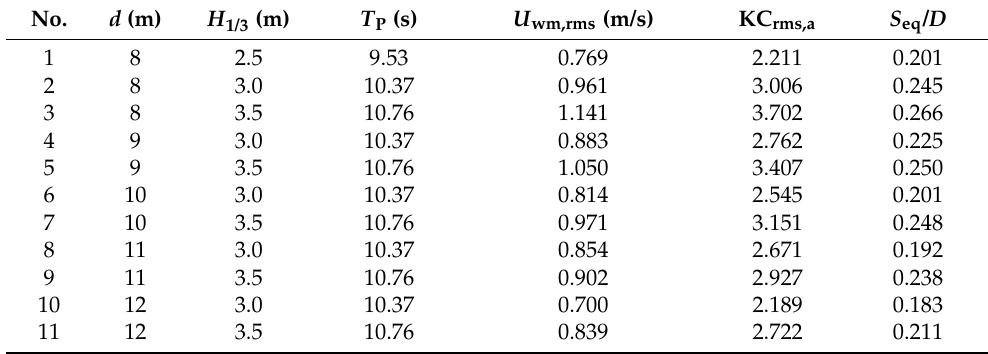
Table 1. Test plans and numerical